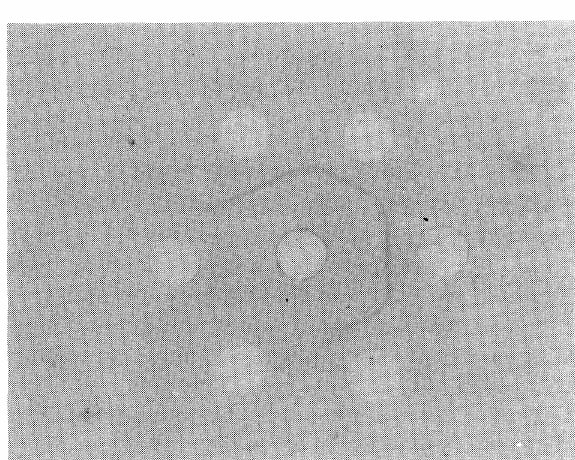
FIG. 1. Double diffusion characterization of rabbit anti-rat cathepsin G antiserum. Samples were: central basin; rat PMN extract; outer basins, four basins contained different rabbit anti-rat cathepsin G IgG-fractions, two basins were empty.